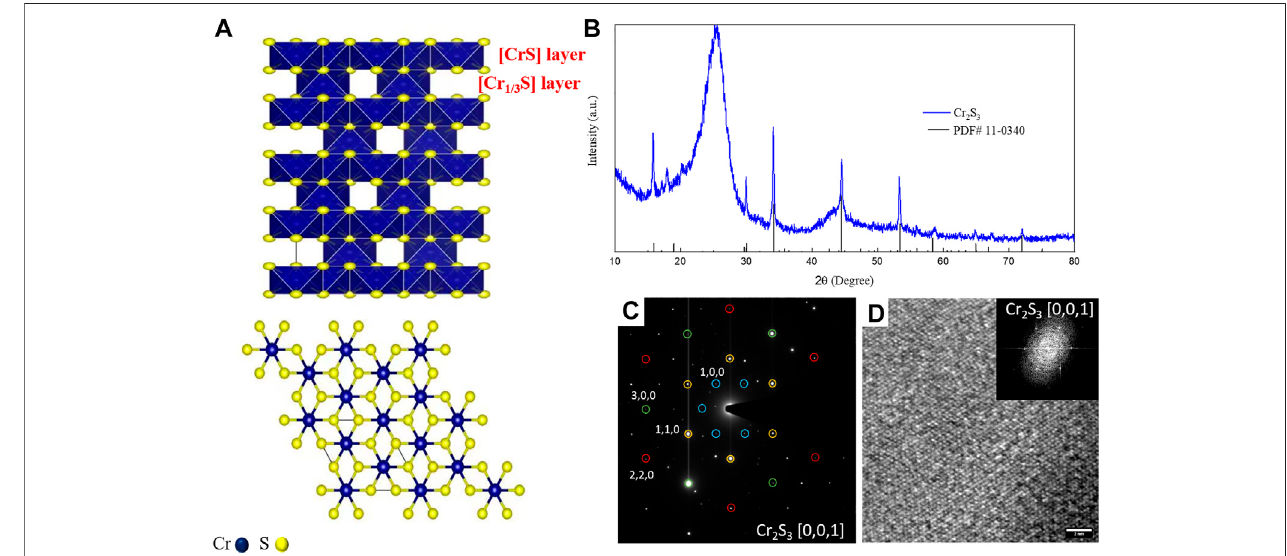
FIGURE 3 | Crystal structure analysis. (A) Structural models of rhombohedral Cr 2 S 3 showing top view and perspective view. XRD pattern (B) , SAED (C) and HRTEM (D) image of Cr 2 S 3 .